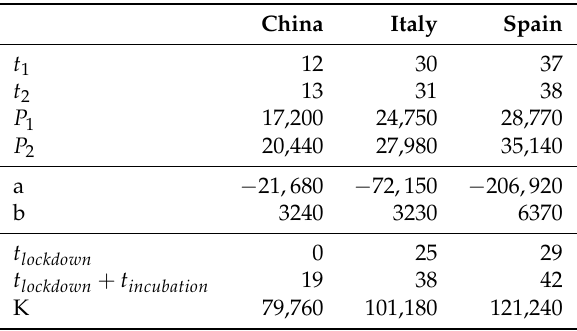
Table 2. Parameter K